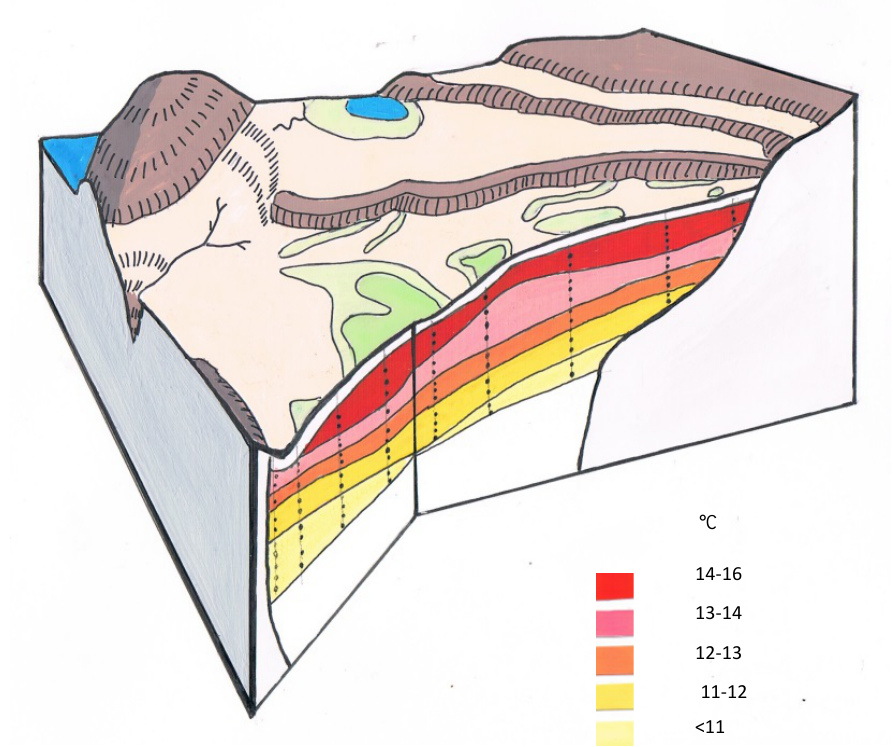
Figure 6. Temperature profiles on Transects I and II. Vertical dots indicate measuring